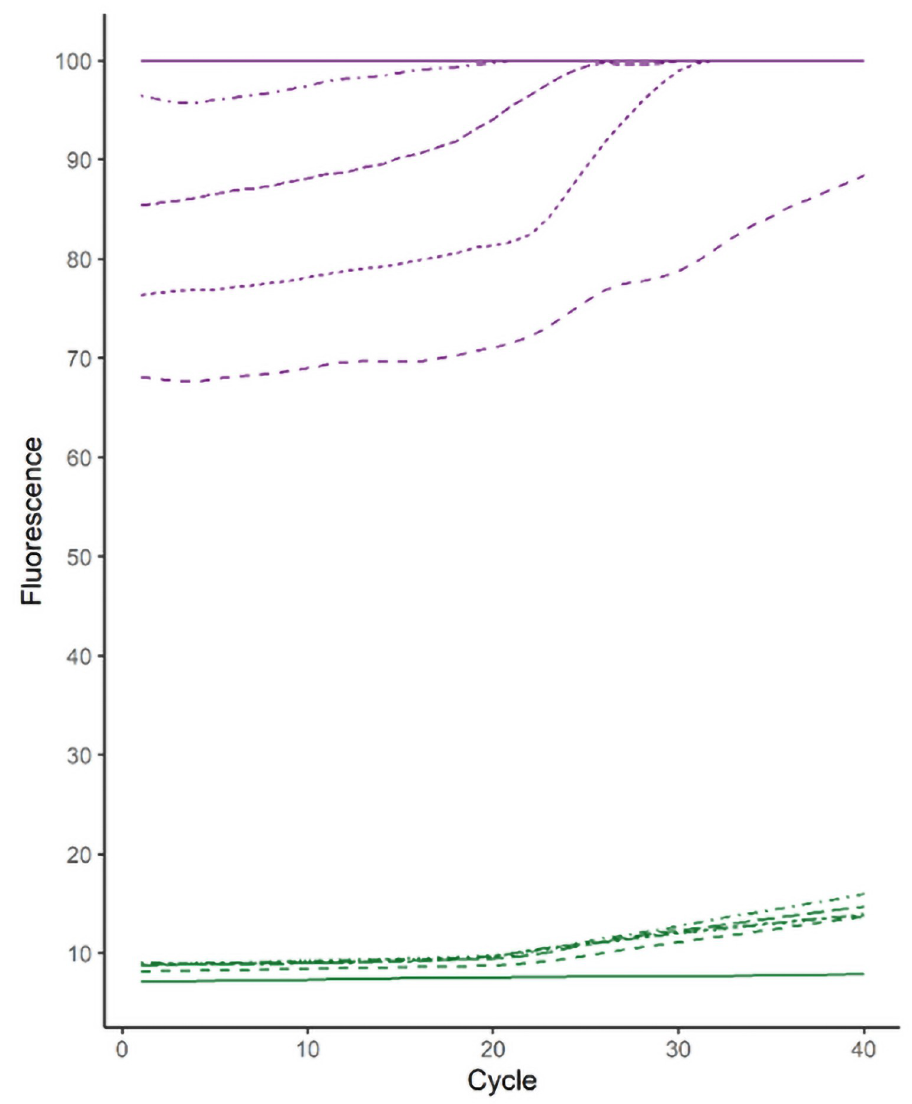
Fig 4. Comparative raw fluorescence data between PanPV and updated PanPV from six poliovirus isolates. Percentage of raw background fluorescence values from standard PanPV assay, purple broken lines (n = 4) and purple solid lines (n = 2) that overlap at the maximum detectable signal (where samples increased 100%). Green lines are the fluorescence measured from the updated PanPV probes tested with the same isolates in the Rotor-Gene